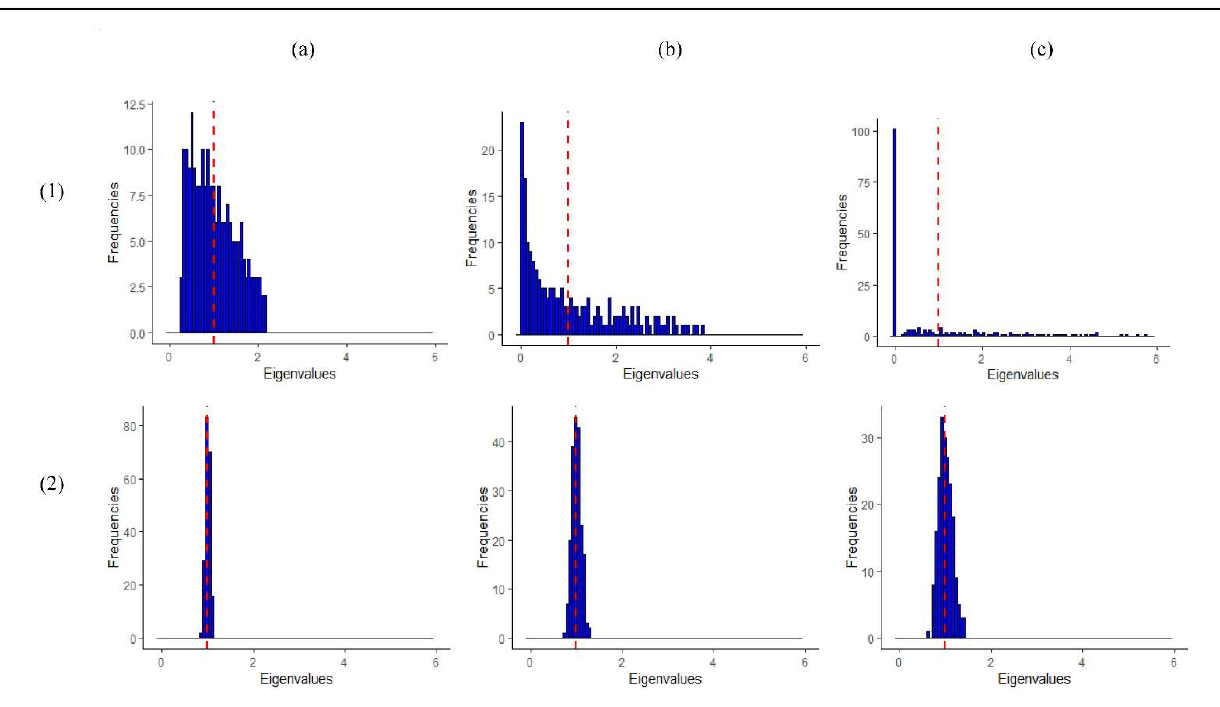
Figure 1. Estimates of the eigenvalues of the covariance matrix of the reference class for ( a ) 800, ( b ) 200, and ( c ) 100 reference observations and 200 variables (metabolites). The top and bottom rows correspond to the sample and (“L LW”) eigenvalue- shrinkage estimates of the covariance matrix, respectively. The data are i.i.d. samples from N(0, Σ ) with population covariance matrix Σ = I , i.e., the population eigenvalues are all equal to one as is indicated by the vertical red dashed line. In line with the simulation settings performed in rest of the paper, the data is auto-scaled. Note that, in particular, the dispersion of the sample eigenvalue estimates around the population value increases when the number of observations decreases. This result is generally observed and not restricted to the case shown here